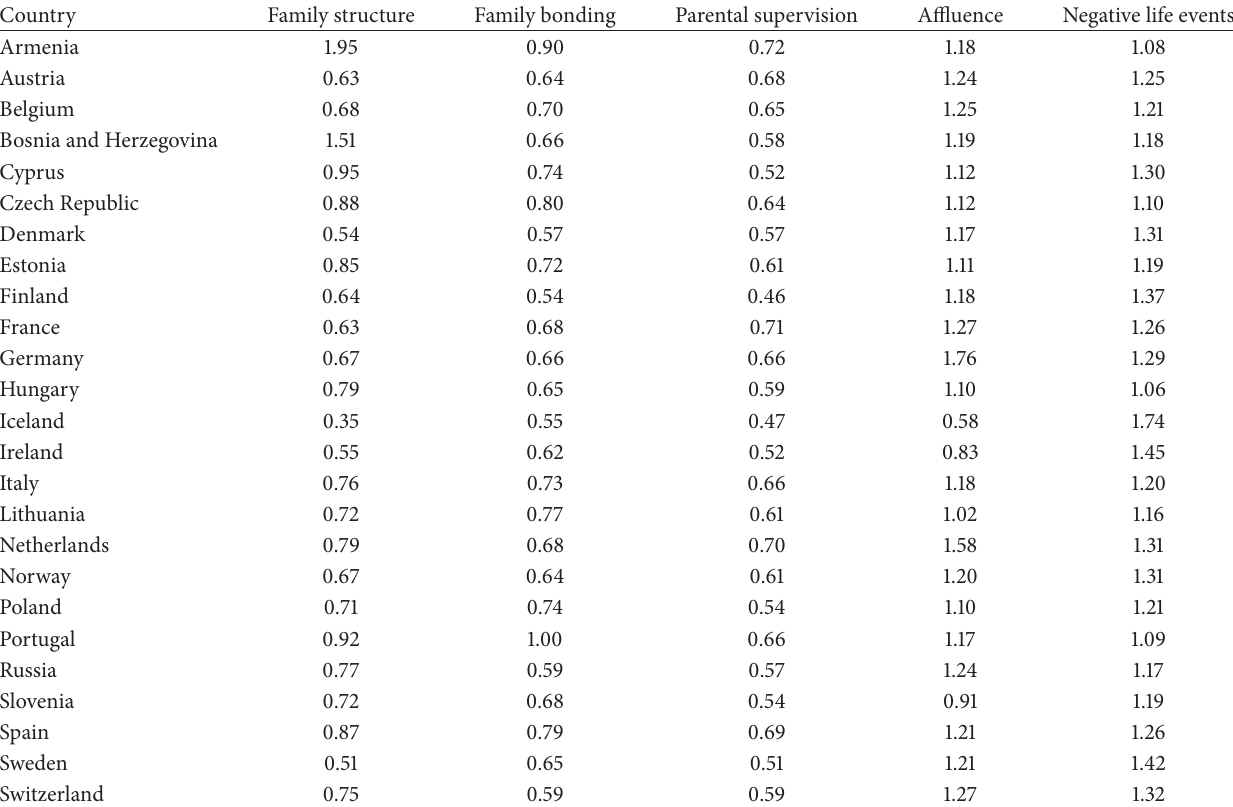
Table 3: Adjusted odds ratios for five family variables by country (controlled for gender, grade, and migrant